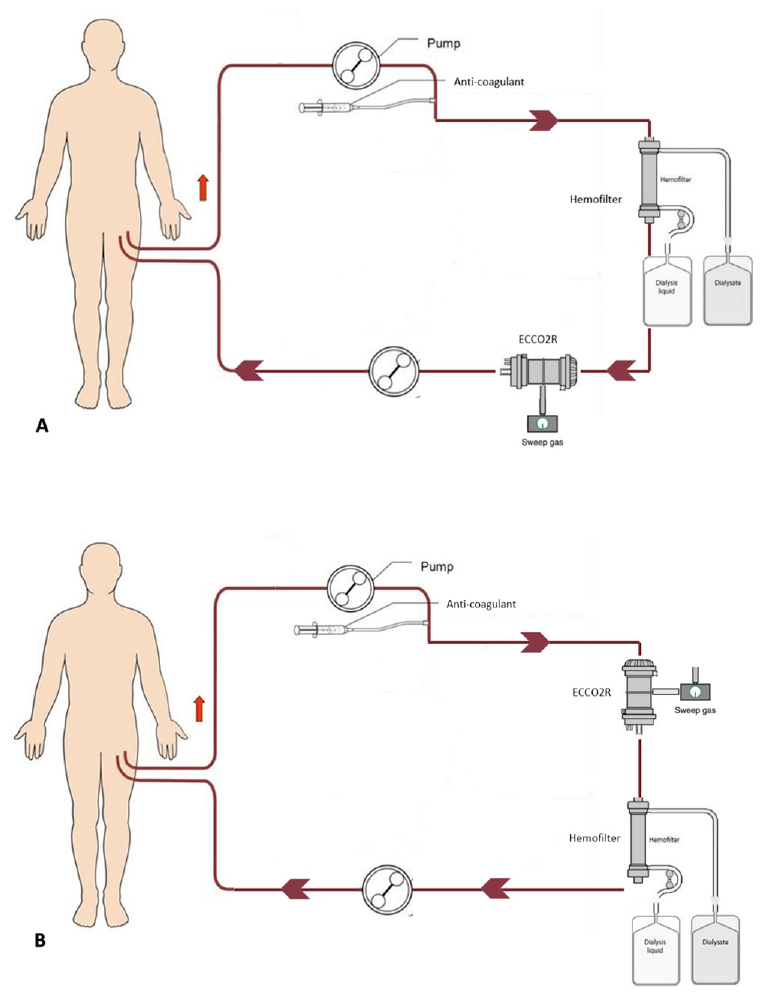
Figure 1. Exemplificative schemes of combined ECCO 2 R–CRRT configurations. In the example CRRT is provided according to CVVHD modality. Membrane oxygenator for ECCO 2 R may be inserted either downstream ( A ) or upstream ( B ) of the